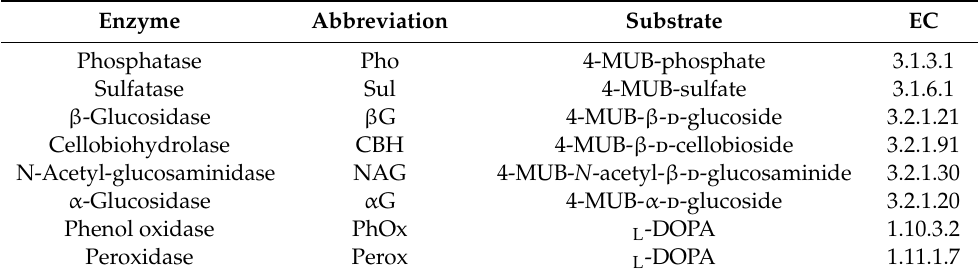
Table 1. Enzymes with corresponding enzyme commission (EC) numbers and substrates. 4-MUB, 4-methylumbelliferyl; L -DOPA, L